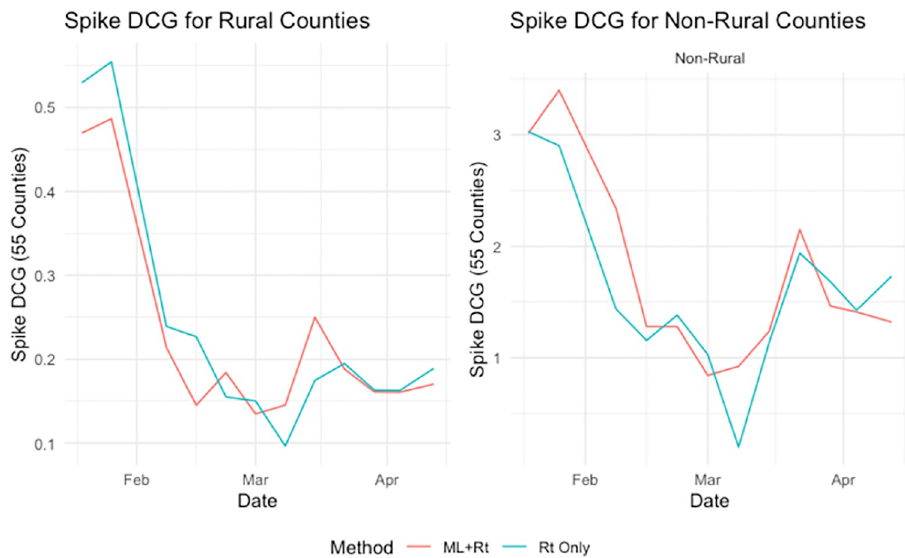
Fig 6. A comparison of Spike DCG for both rural and non-rural